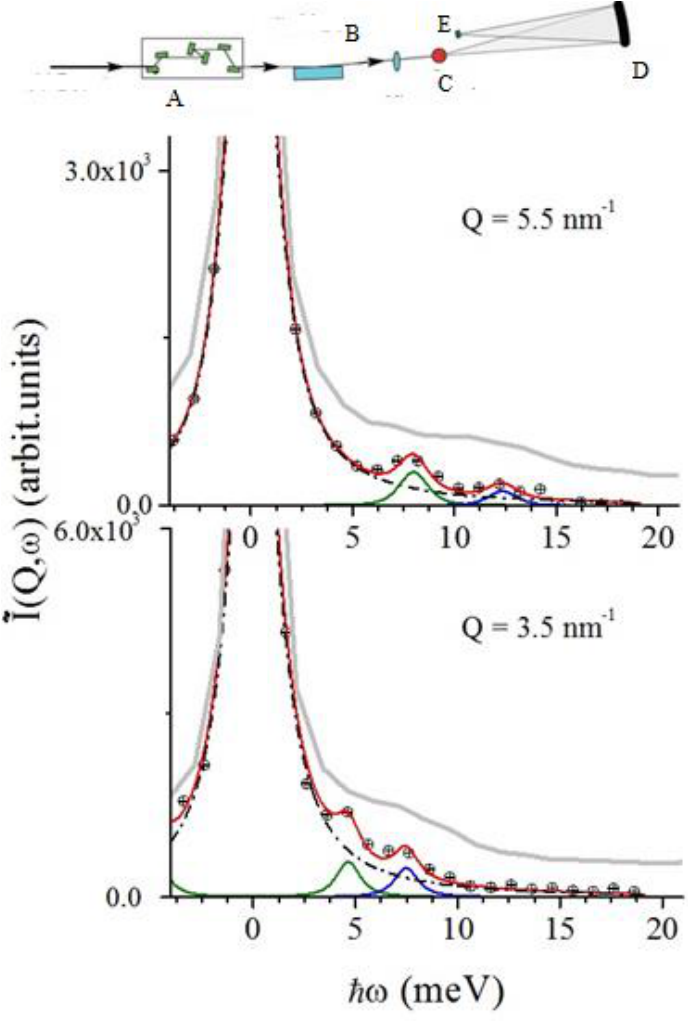
Figure 5. Top panel : the IXS instrument used to perform the measurements reported, whose main components are: ( A ) in-line monochromator, ( B ) beam focusing unit, ( C ) sample ( D ), spherical analysers (nine simultaneously working in a single scan), ( E ) detector. Bottom panel : IXS spectra (open circles) of the Au NP suspension measured at few representative Q values. The best fit lineshapes by the RJ-MCMC algorithm are also reported as red solid lines along with the low (green solid line) and high-frequency (blue solid line) inelastic excitations as well as the quasielastic Lorentzian component (black dashed-dotted line). Finally, the spectra measured on pure water in a previous IXS work [54] at close Q values ( Q = 4 nm − 1 and 6 nm − 1 in the lower and upper panel respectively) are also reported as a thick grey line after a re-scaling to the same maximum of the colloidal suspension spectrum. Error bars on the measured spectral shapes are within the symbol size. Reprinted with permission from Ref. [19]. Copyright (2018) American Chemical